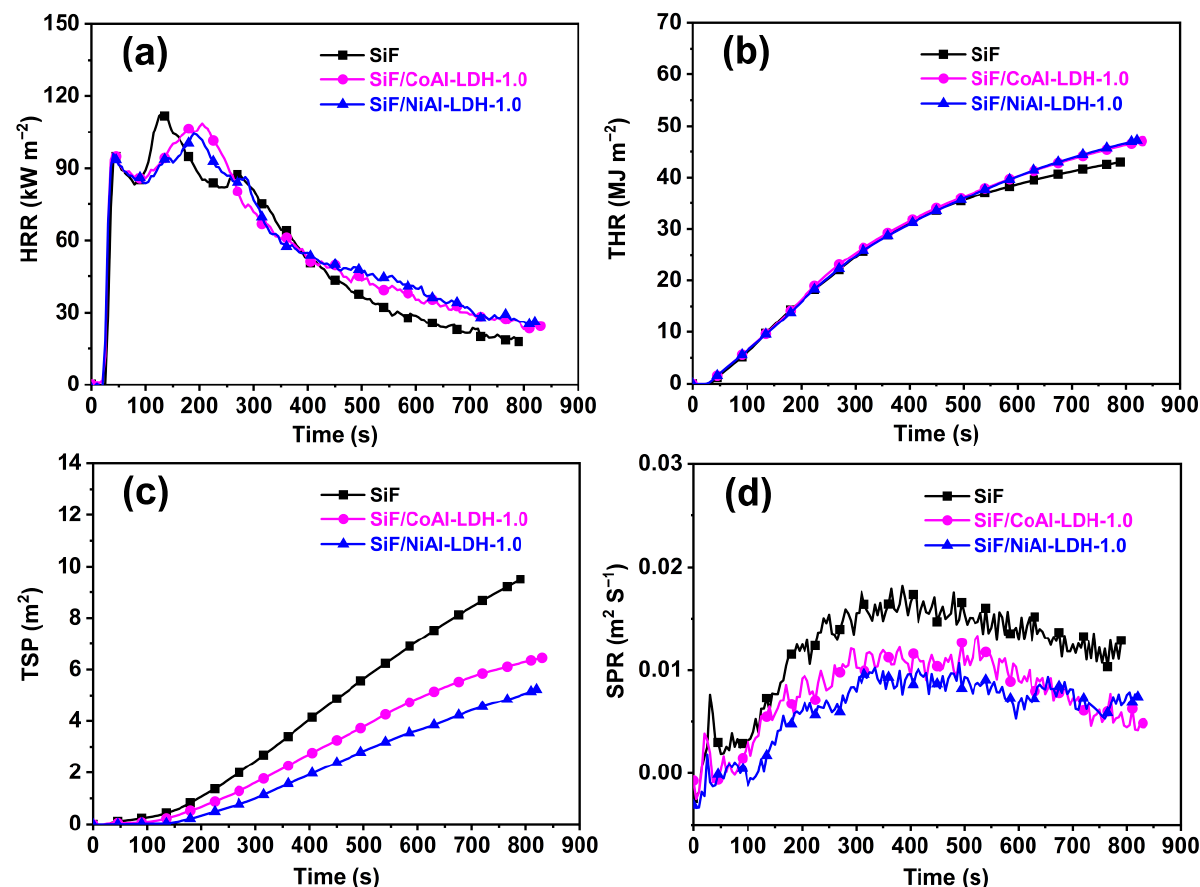
Figure 6. Typical curves derived from the cone calorimeter tests: ( a ) HRR, ( b )THR, ( c ) TSP, and ( d ) SPR curves. Table 3. Data on the SiF/LDH nanocomposites from the cone calorimeter tests.